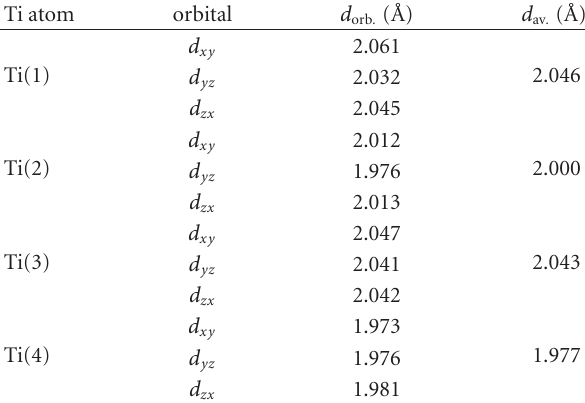
Table 7: The averaged Ti–O distances in the plane of t 2 g orbitals ( d orb . ) and in the oxygen octahedra ( d av . ) for P 1 structure of Ti 4 O 7 . d xy approximates to the occupied orbital of the 3 d 1 Ti(1) and Ti(3) 3+ states